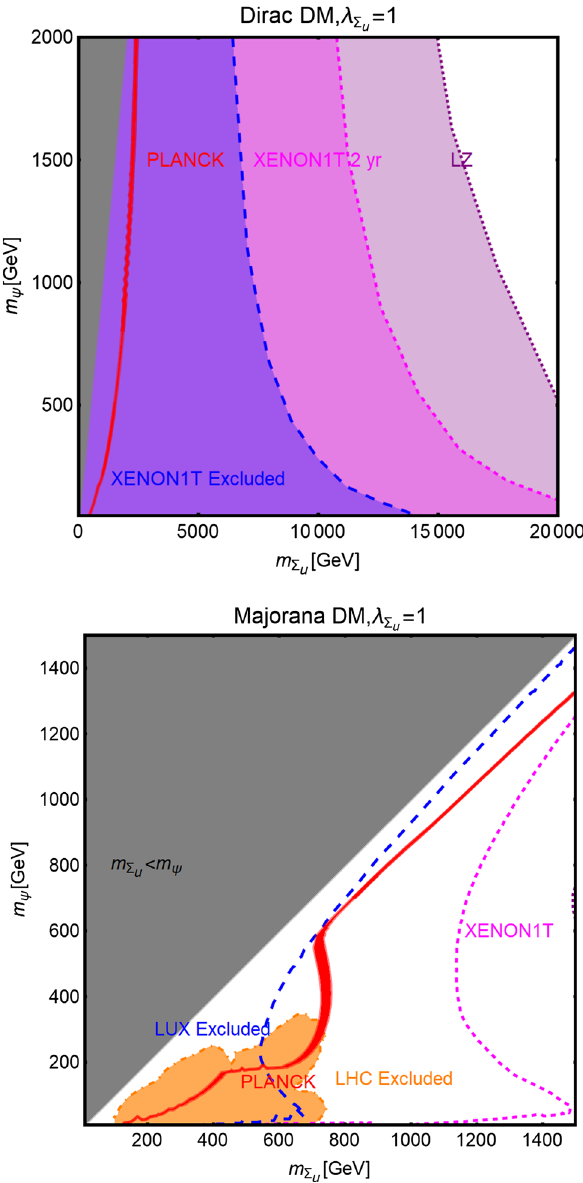
, m ψ ) bi-dimensional u has u